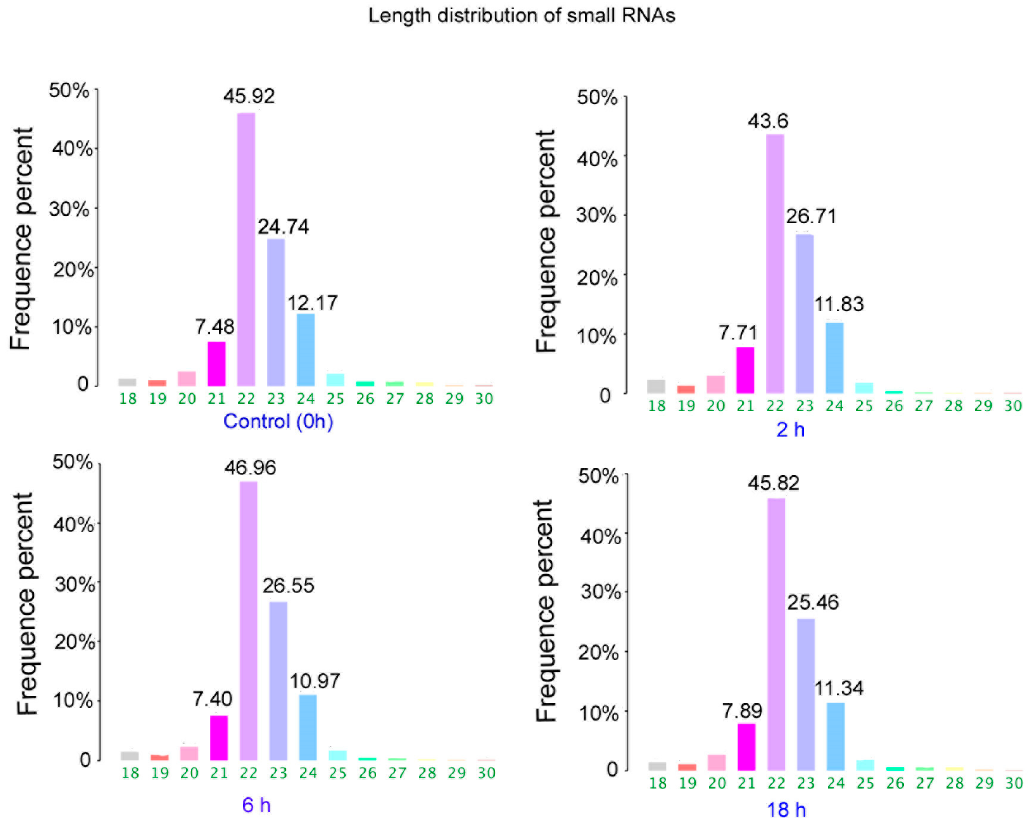
Figure 3. Length distribution of small RNAs in control and ZEA treated groups.